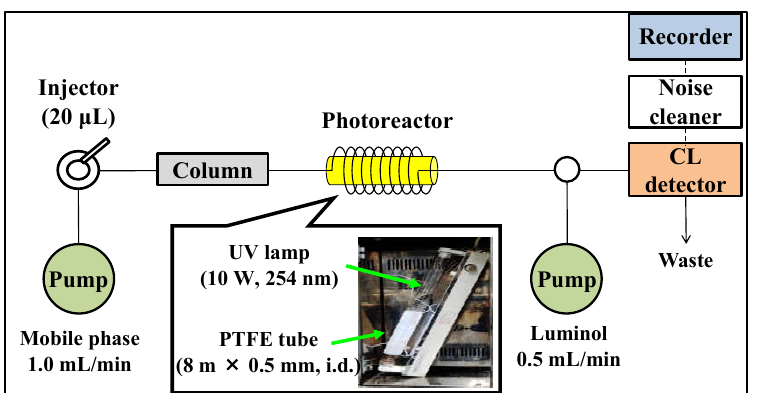
Figure 2. Scheme diagram for the HPLC with online photoreactor and luminol CL detection system.